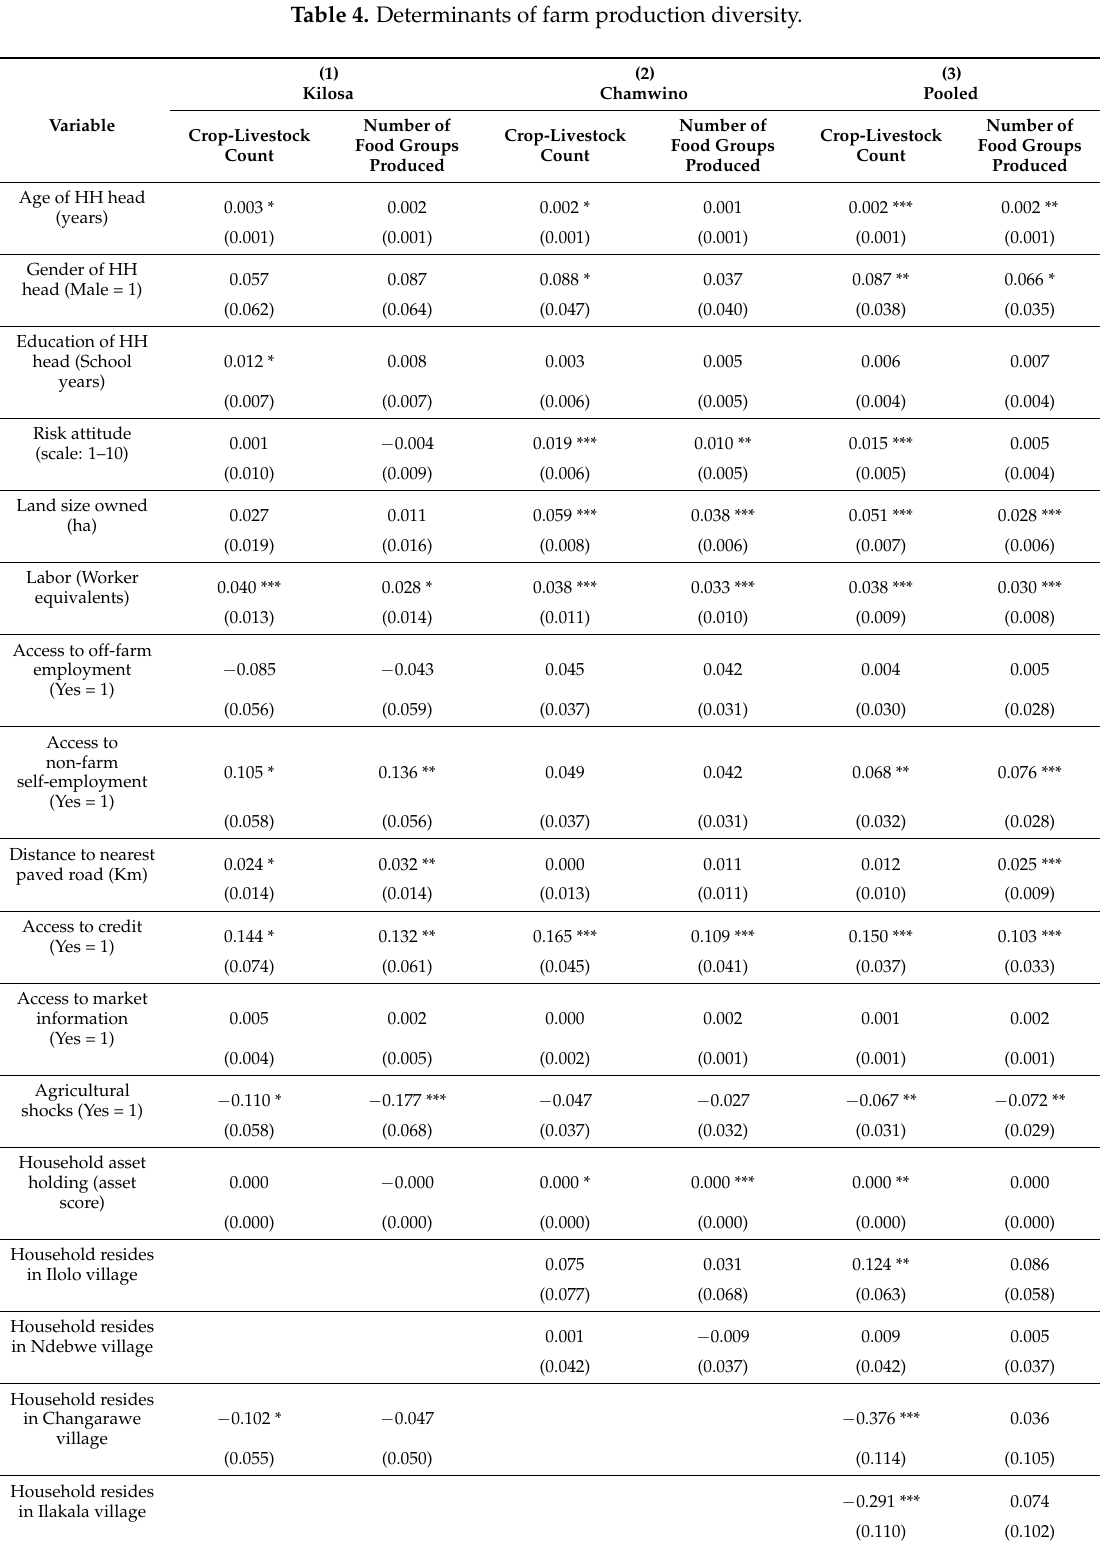
Table 4. Determinants of farm production